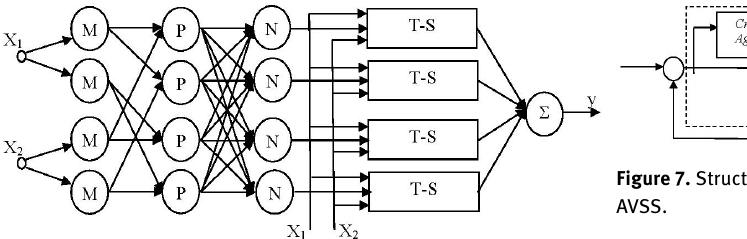
Figure 5. A sample neurofuzzy structure equivalent with a MISO TSK fuzzy inference system.